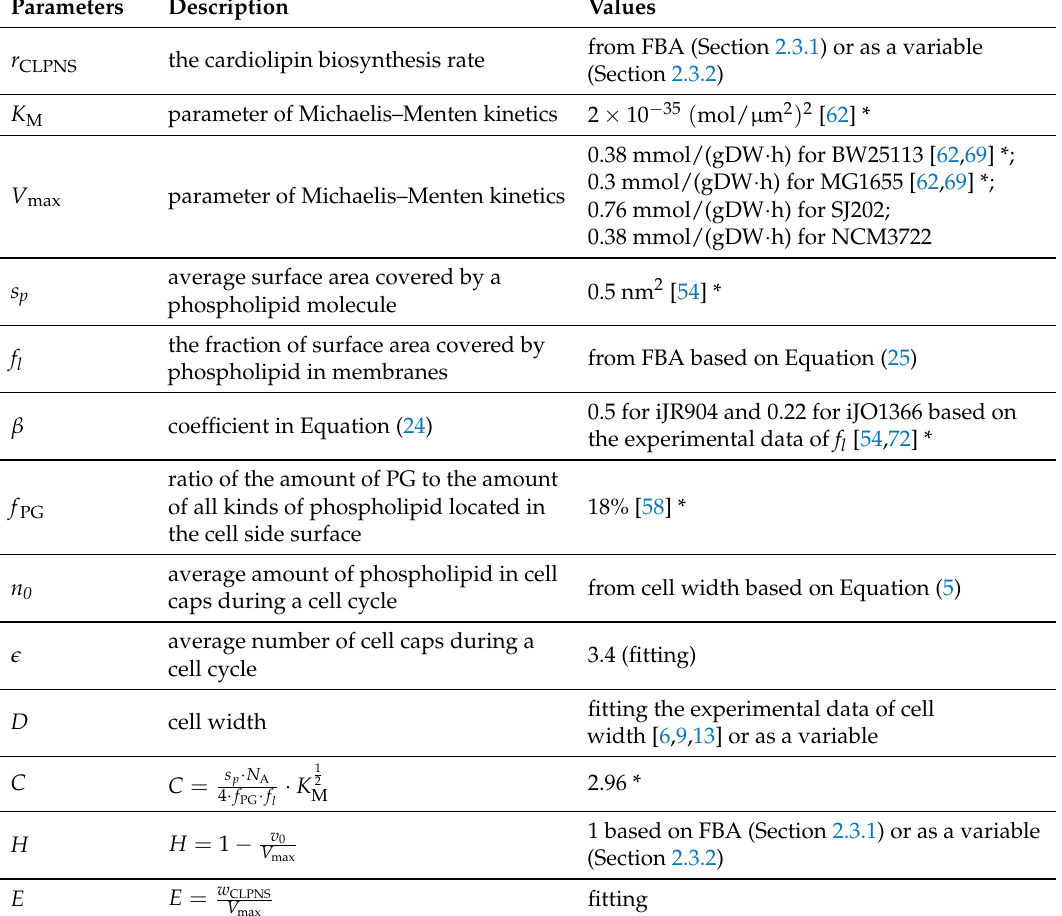
Table 1. Parameters and variables involved in this